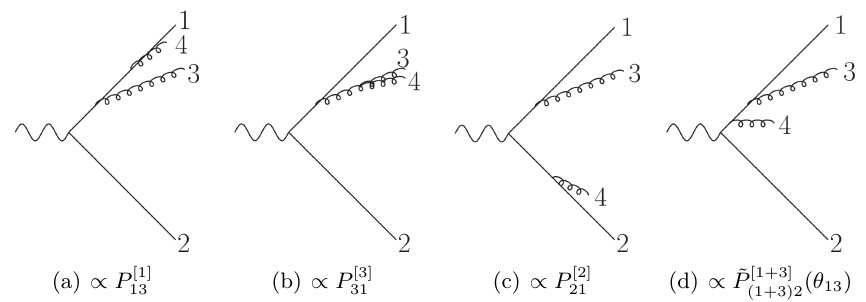
Figure 4 . Diagrams illustrating the angular ordered interpretation of γ ∗ → q (1) ¯ q (2) g (3) g (4) . The relative lengths of lines depict the relative energies of the particles. Likewise, the angles between lines are indicative. These terms are computable from A 4 in the limit that particle 3 is collinear to particle 1 , and particle 4 is soft. As the amplitude density matrix is diagonal, these diagrams can be considered representative of contributions at cross-section